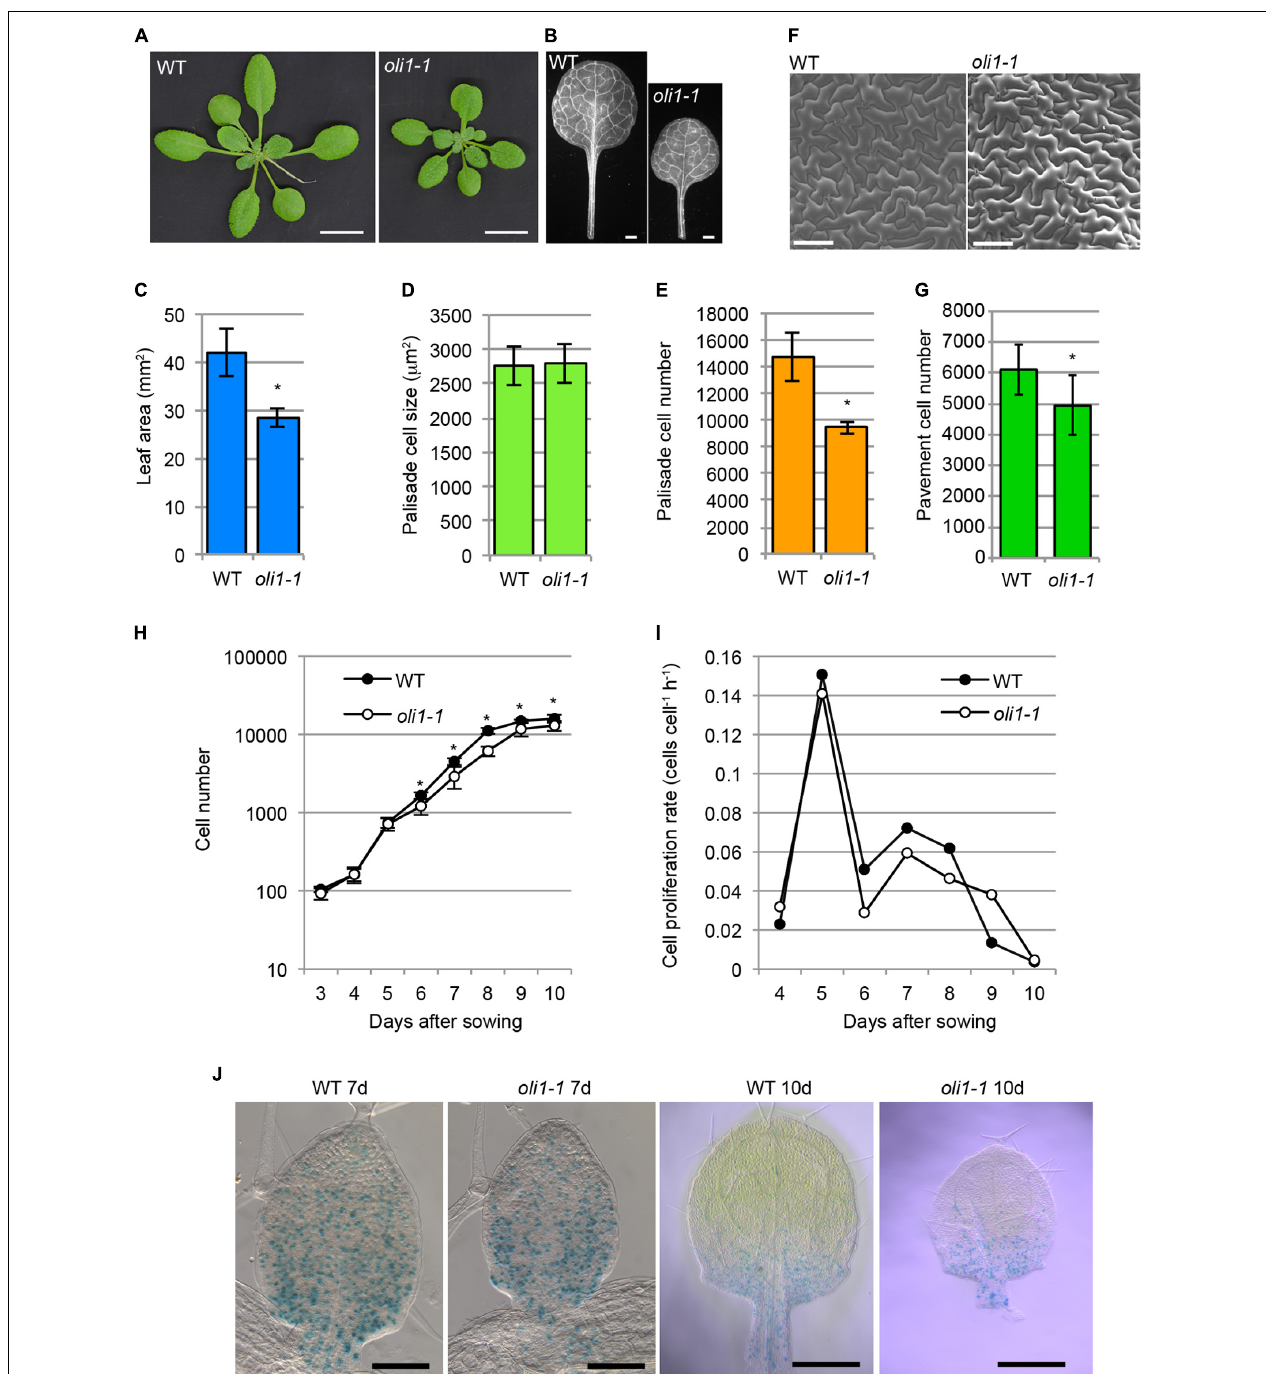
FIGURE 1 | Characterizations of the leaf phenotypes in oli1-1 . (A) Shoots of wild-type (WT) and oli1-1 . (B) First leaves of WT and oli1-1 . (C) The areas of the first leaf blades. (D,E) Quantitative phenotypes of palisade cells in the adaxial subepidermal layer (hereafter called palisade cells for simplicity) of the first leaves of WT and oli1-1 . The projection areas of palisade cells of the first leaves (D) , and estimated palisade cell numbers (E) are shown. (F) Adaxial epidermis in the first leaves of WT and oli1-1 observed under a scanning electron microscope. (G) Pavement cell numbers in the adaxial epidermal tissue first leaves. (H,I) Time course analysis of first leaf development. Changes in the cell number (H) and cell proliferation rate (I) were determined by observing the palisade cell layers of first leaf primordia at the indicated days after sowing. (J) Expression pattern of p CYCB1;1 :: GUS in WT and oli1-1 grown for 7 (left two panels) and 10 days (right two panels). Scale bars in (A) and (B) correspond to 1 cm and 1 mm, respectively, those in (F) and the left two panels in (J) are 100 µ m, and those in the right two panels in (J) are 0.5 mm. In (A–G) , the samples were harvested at 21 days after sowing. In (C–H) , the data are shown as means ± SD ( n = 10), and asterisks indicate statistically significant differences between WT and oli1-1 (Student’s t -test, p < 0.05). In (I) , the data were calculated from those shown in (H)